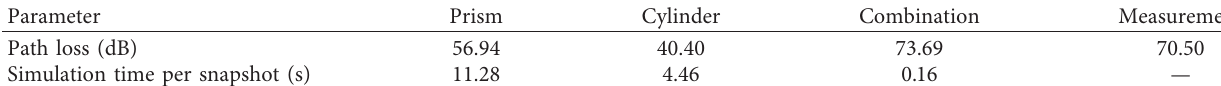
Table 8: Simulation and measurement results around the waist.